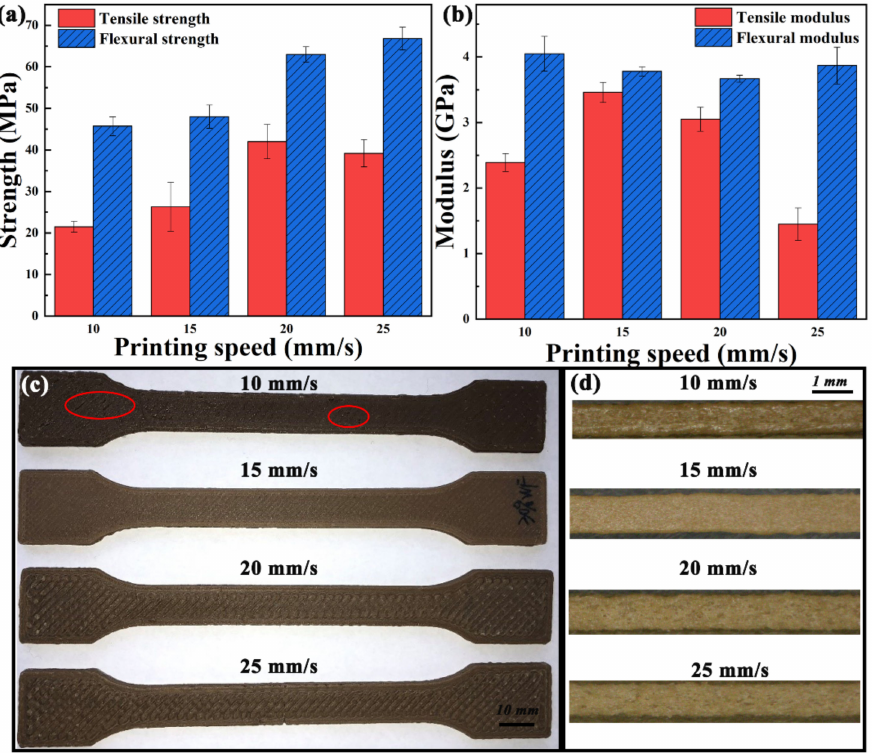
Figure 10. ( a ) Mechanical strength and ( b ) modulus, and ( c ) surface quality of samples printed at various printing speeds. ( d ) Microscope images of deposited filament morphology at various printing